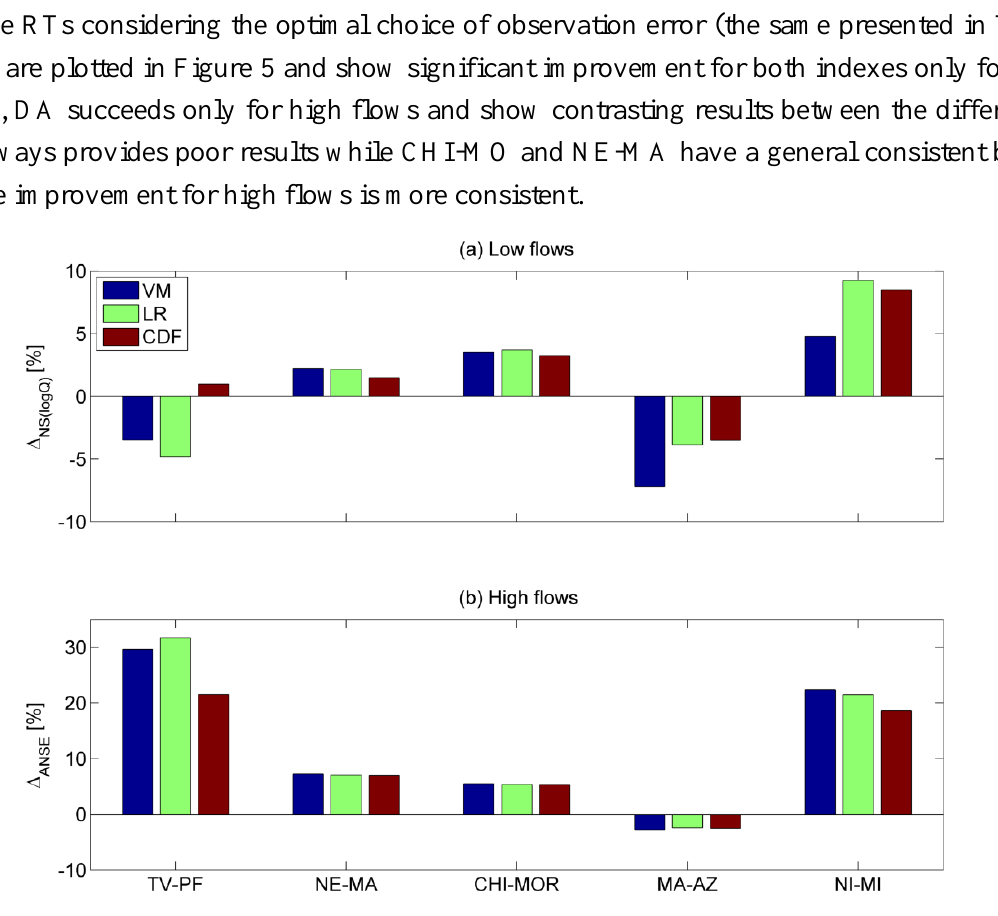
Figure 5. Differences (Δ NS(logQ) , and Δ ANSE ) between performance scores NS (logQ) and ANSE obtained prior and after the assimilation of SM for the five selected catchments. While ( a ) NS ( logQ ) is well suited for highlighting the performance in the reproduction of low flows, ( b ) ANSE is used for characterizing the agreement of high flows. The related observation errors are the same as selected in Table